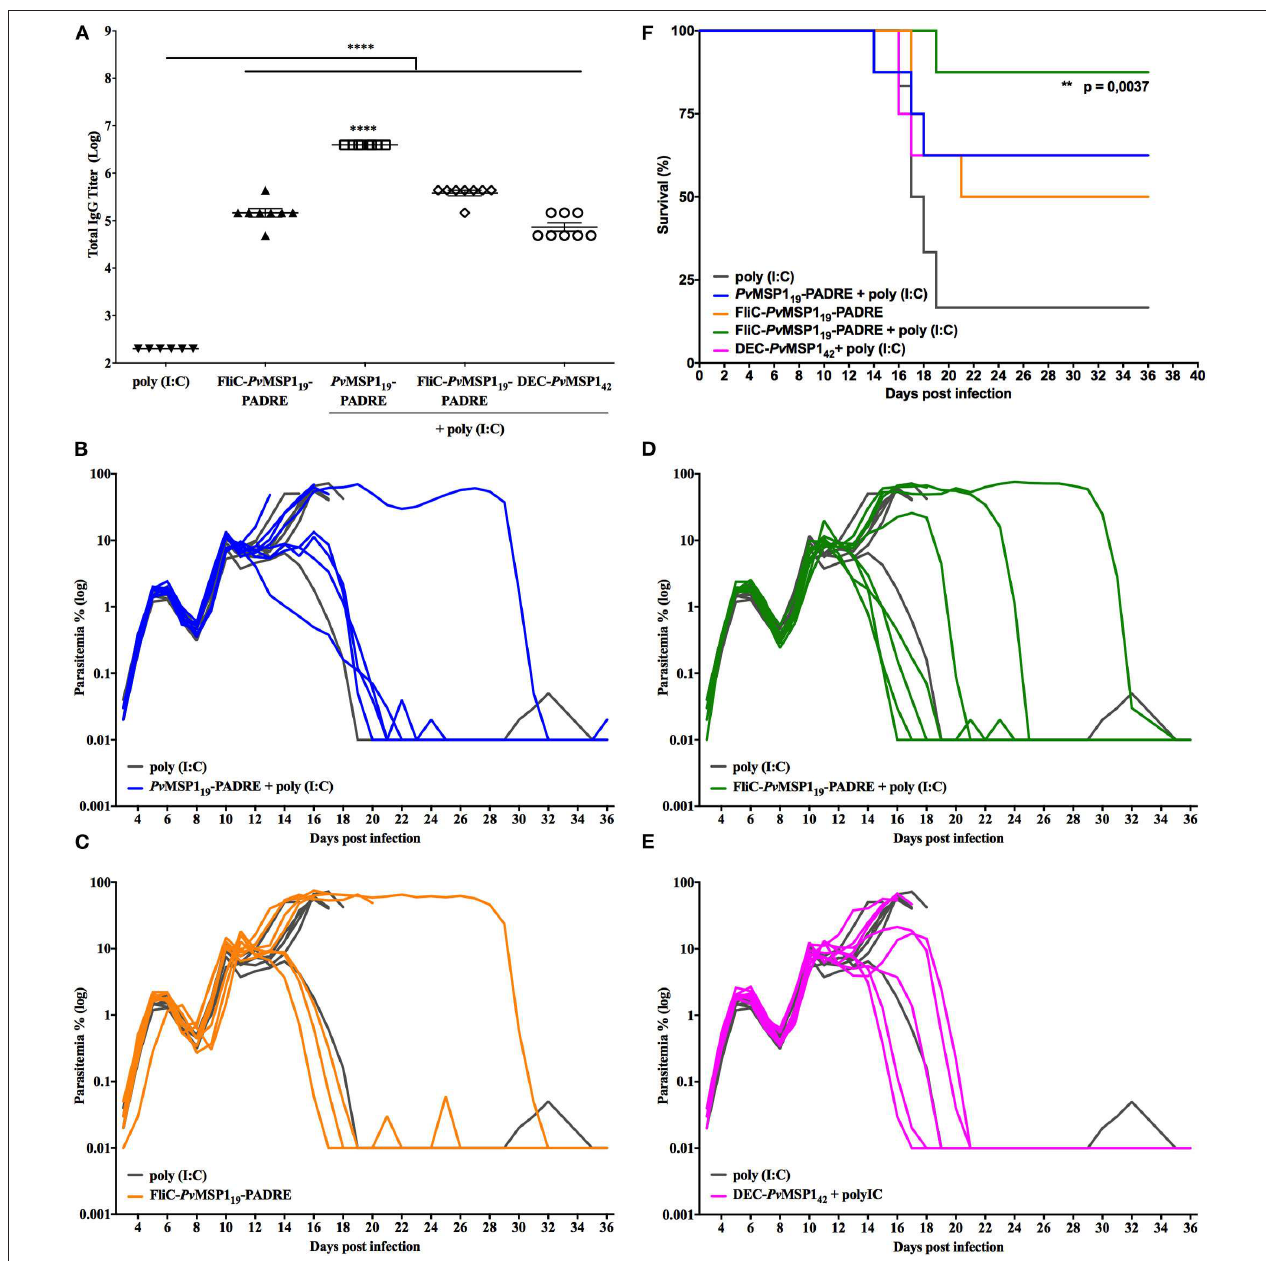
FIGURE 6 | Immunizations with HIS 6 -FliC- Pv MSP1 19 -PADRE + poly (I:C) protects BALB/c mice from challenge with Pb/Pv MSP1 19 GFP NK65 . BALB/c mice ( n = 8) were vaccinated with three immunizing doses of HIS 6 - Pv MSP1 19 -PADRE + poly (I:C), HIS 6 -FliC- Pv MSP1 19 -PADRE, HIS 6 -FliC- Pv MSP1 19 -PADRE + poly (I:C), α DEC- Pv MSP1 42 + poly (I:C), or poly (I:C) alone as a control ( n = 6). HIS 6 - is omitted from the name of the recombinant proteins in the figure. (A) Total IgG titers (Log) after the third immunizing dose. Each symbol represents one animal of the indicated groups. (B–E) Mice were challenged i.v. with 5 × 10 3 red blood cells infected with the hybrid line Pb/Pv MSP1 19 GFP NK65 and the parasitemia was followed daily by flow cytometry. Each line represents one mouse of the indicated groups. (F) Mortality curves of the indicated groups. One-way ANOVA followed by Tukey’s HSD test: ** p < 0.01 and **** p < 0.0001. For mortality curves: Mantel-Cox test. parasitemia increased in almost all mice in the control group, group immunized with HIS 6 -FliC- Pv MSP1 19 -PADRE + poly which died between days 16 and 19 post-challenge ( Figure 6F ). (I:C), only one mouse died from infection ( Figure 6D ), with this formulation being the most efficient in inducing protective immunity in BALB/c mice challenged with the P. berghei NK65 mutant